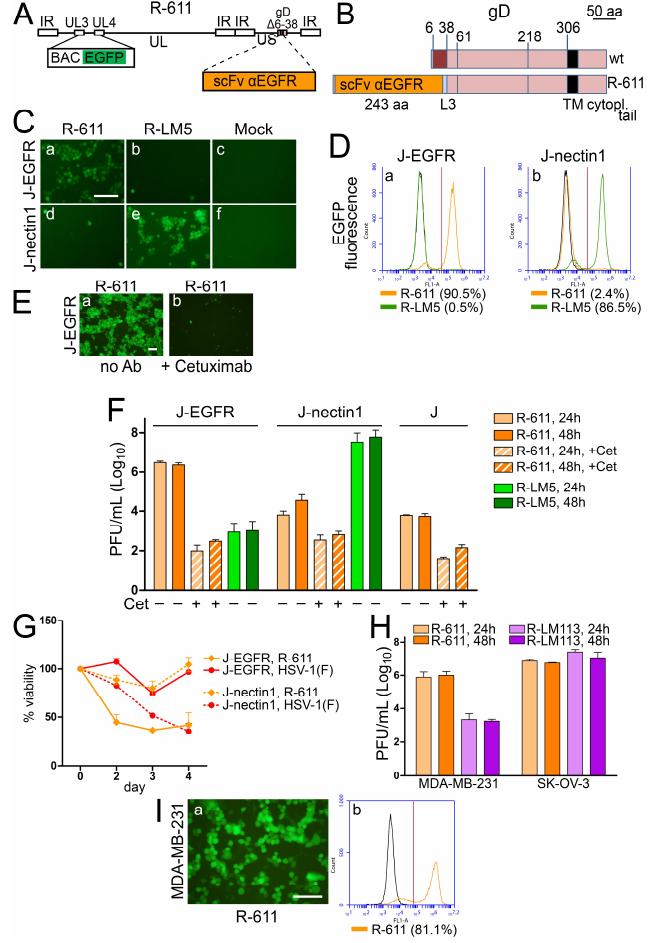
Figure 4. Properties of EGFR-retargeted R-611. ( A ) Schematic drawing of the R-611 genome. The scFv to EGFR was inserted in place of aa 6–38 of gD. pBeloBAC11 and EGFP (BAC EGFP) are inserted between UL3 and UL4 [50]. ( B ) Linear map of wt gD and of recombinant gD in R-611. L3, linker 3. ( C ) J-EGFR and J-nectin1 cells were infected with the indicated viruses at 10 PFU/cell. Pictures were taken at 24 h after infection. The controls in J-nectin1 cells (R-LM5 and Mock) were the same as shown in Figure 2C, since the experiments with different recombinant o-HSVs were run in parallel to facilitate comparison. The levels, brightness, and contrast of the panels were adjusted by means of Adobe Photoshop as follows: input level (black) 30, brightness +60, contrast +60, scale bar = 100 µ m. ( D ) J-EGFR and J-nectin1 cells exposed to 10 PFU/cell of R-611 or R-LM5, or mock infected (black line), were analyzed by flow cytometry for EGFP fluorescence. The controls in J-nectin1 cells (R-LM5 and Mock) are the same as in Figure 2D. The figures next to each virus name denote the percentage of infection. Vertical red line: threshold discriminating the negative and positive populations, as determined by comparison with the negative control. ( E ) Neutralization of R-611 infection in J-EGFR cells by the humanized monoclonal antibody cetuximab directed to EGFR (83 µ g/mL, panel b) or no antibody (no Ab) as control (panel a). Pictures were taken at 24 h after infection. Scale bar = 100 µ m. ( F ) R-611 replication in J-EGFR, J-nectin1, and J cells, infected at 1 PFU/cell, in the absence or presence of cetuximab (Cet), and harvested at the indicated times. The data represent the average of three independent experiments ± SD. R-LM5 replication in J-EGFR and J-nectin1 cells, infected at 1 PFU/cell. The data represent the average of four independent experiments ± SD. ( G ) Effect of virus infection on cell viability. J-EGFR (solid lines) or J-nectin1 (dashed lines) cells were infected at 5 PFU/cell with the indicated viruses. The data represent the average of four replicate samples ± SD. ( H ) R-611 replication in EGFR-positive MDA-MB-231 and SK-OV-3 tumor cells infected with at 1 PFU/cell and harvested at 24 and 48 h. Bars represent the average of two independent experiments ± SD. ( I ) Infection of MDA-MB-231 cells was documented by fluorescence microscopy (panel a) and quantified by flow cytometry (panel b). Scale bar = 100 µ m. Vertical red line: threshold between negative and positive